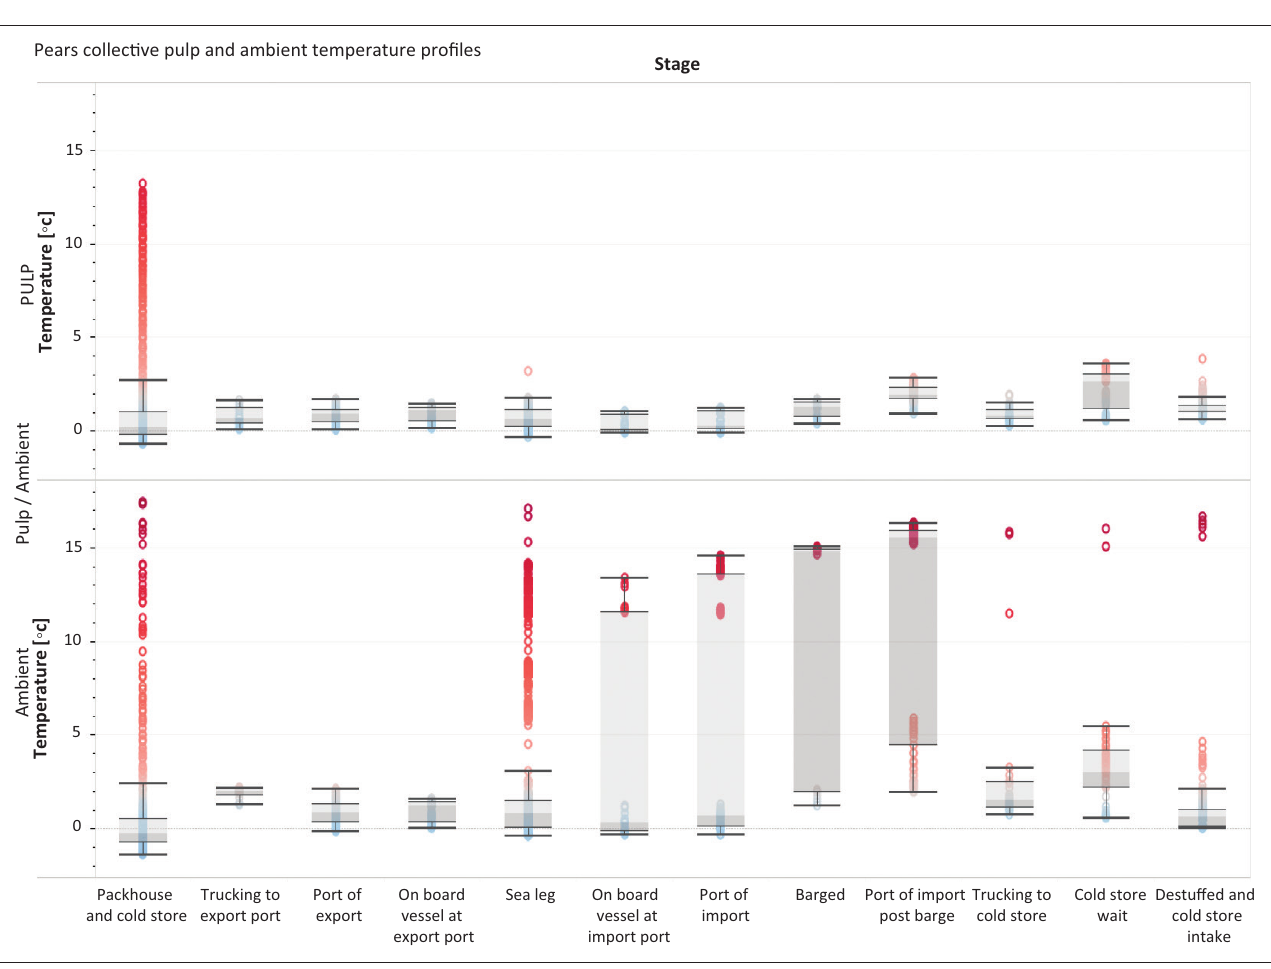
FIGURE 4: Pear trials collective temperature profiles box and whisker